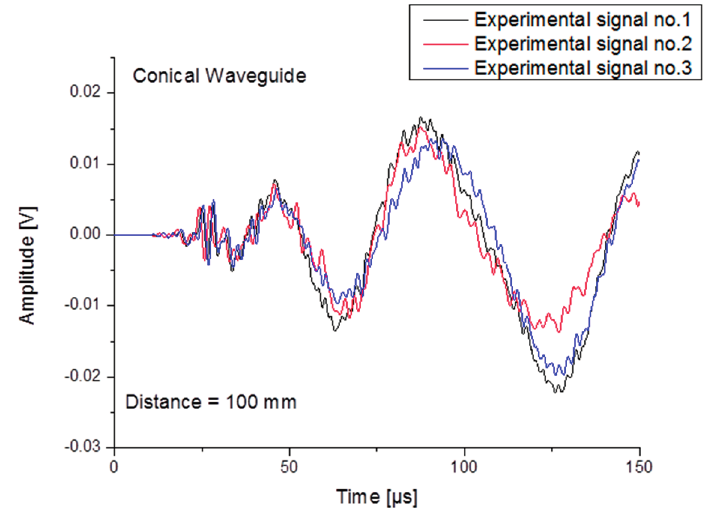
Figure 7. Experimental WG signals generated by different